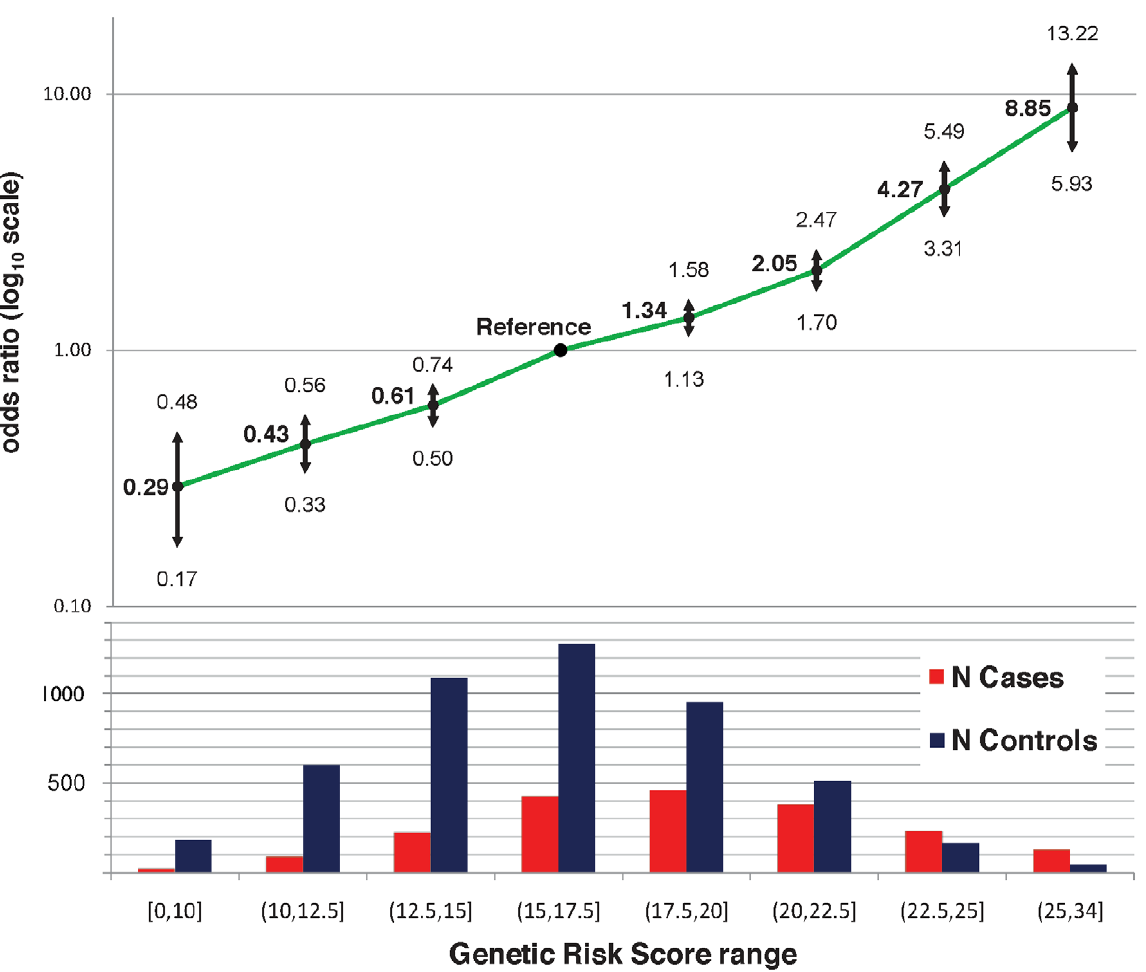
Figure 2. Odds ratio of GRS intervals, adjusted for four principal components, two parent studies, and gender. Sample sizes for each interval are shown below the graph.